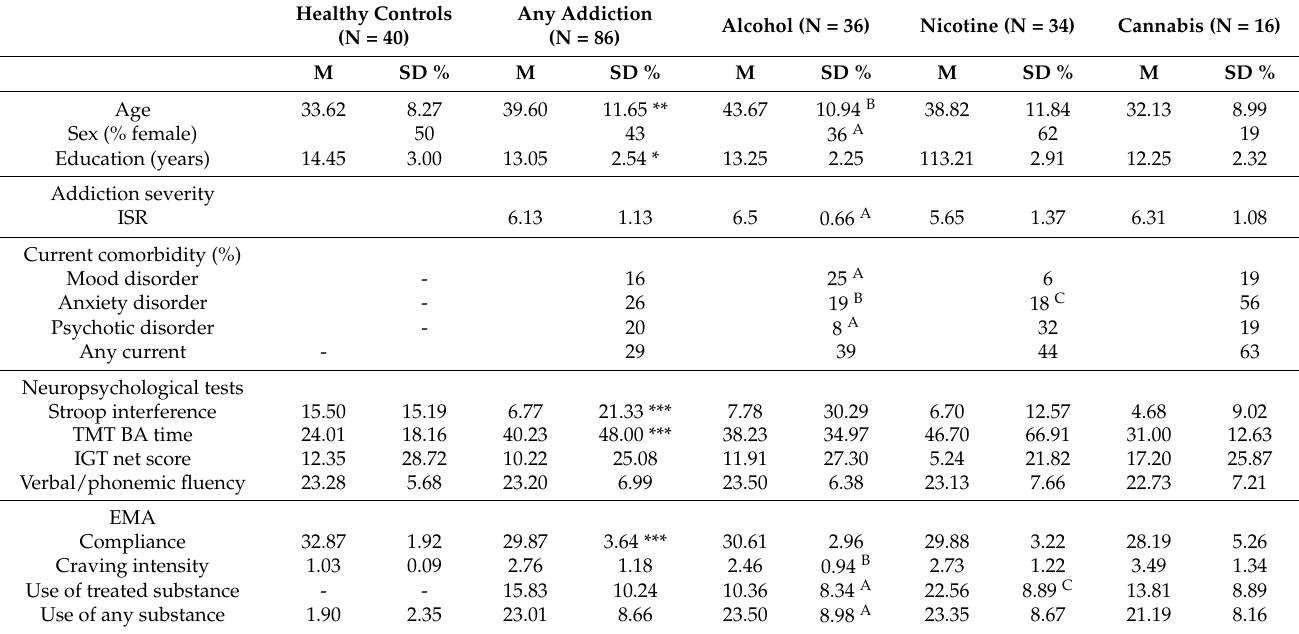
Table 1. Description of the sociodemographic, clinical and EMA variables of the